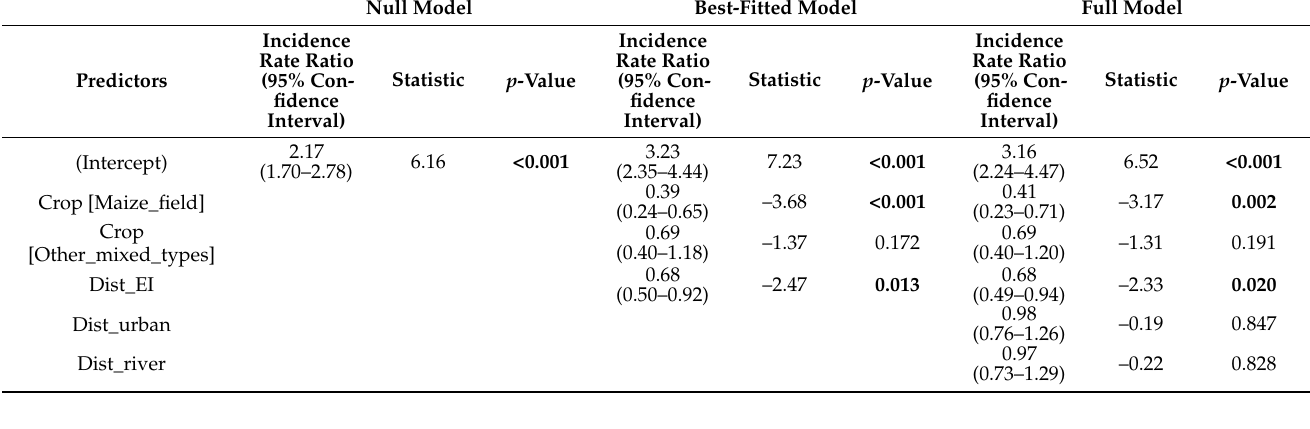
Table 2. Summary of the GLMM best-fitted model compared with the Null and Full models, to test Hypothesis 3. Significant p -values ( p < 0.05) are displayed in bold.